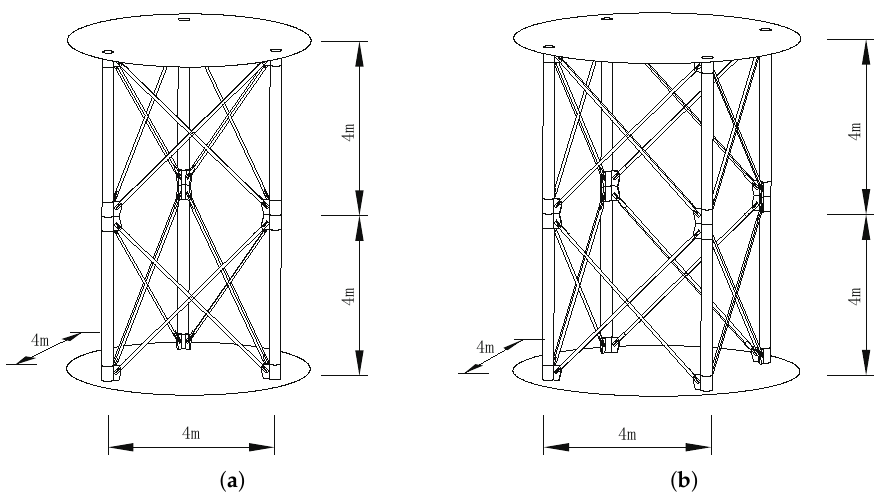
Figure 6. ( a ) The structural dimensions of the triangular lattice tower. ( b ) The structural dimensions of the quadrilateral lattice tower.